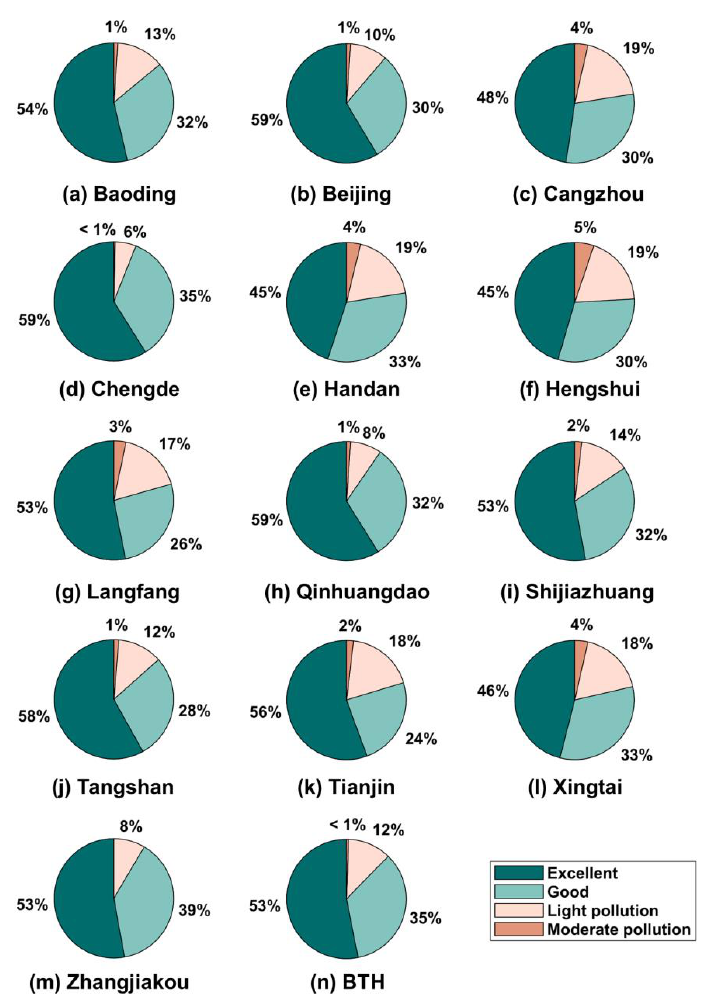
Figure 7. O 3 pollution level in each city of the BTH region in 2018.